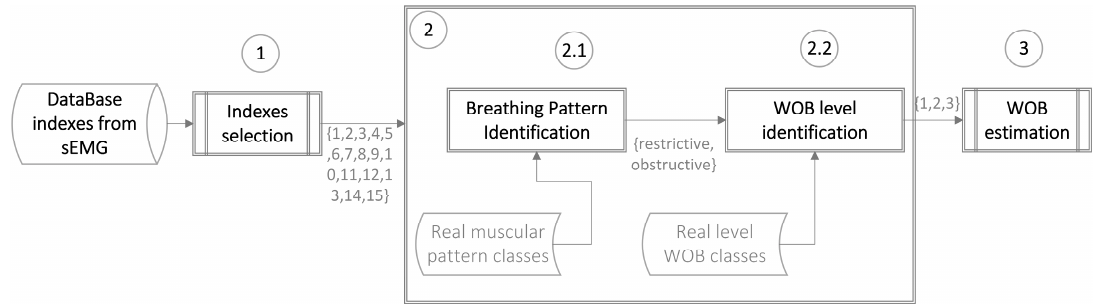
Figure 3. Methodology to estimate the level of WOB from sEMG signals. 1—determining which of 15 indexes from the sEMG signals are relevant to describe the breathing pattern and the work of breathing. 2—classification steps: 2.1—identifying if the breathing pattern corresponds to a